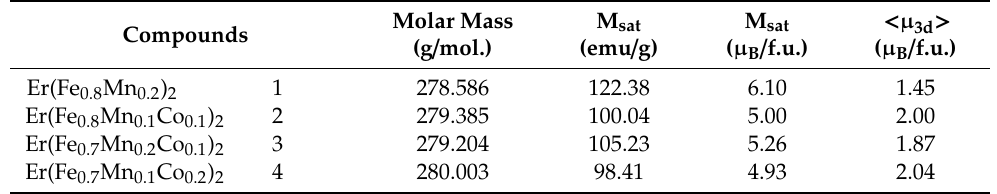
Table 2. Total magnetic moments and TM moments for Er(Fe 0.8 Mn 0.2 ) 2 , Er(Fe 0.8 Mn 0.1 Co 0.1 ) 2 ,